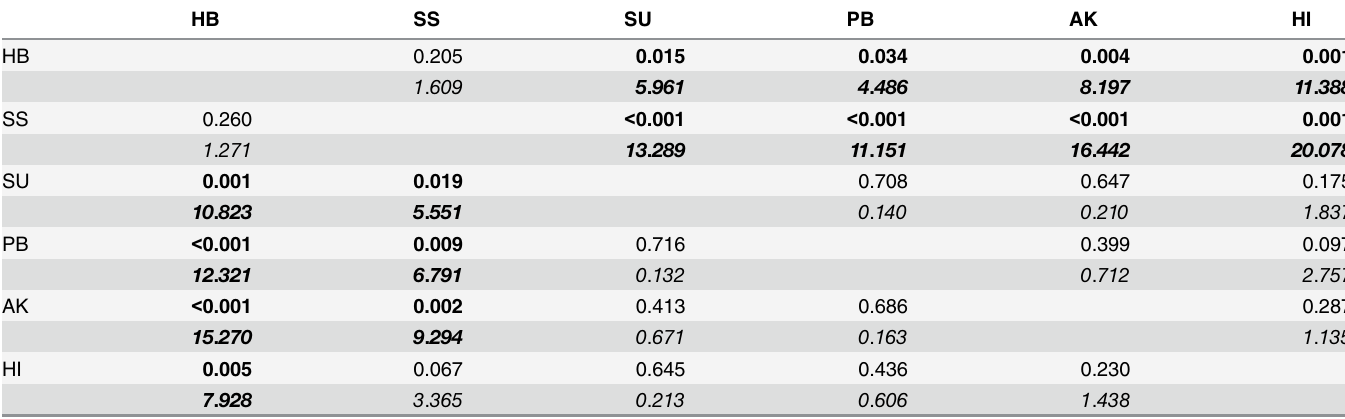
Above the diagonal refers to comparisons made for δ 15 N values. Below the diagonal refers to comparisons made for δ 13 C values. For each cell, the top number is the p-value and the bottom number (in italics) is the Chi 2 value. P-values < 0.05 and associated chi-square values are in bold. HB = historical breeders. SS = sequentially successful breeders. SU = sequentially unsuccessful breeders. PB = prebreeders. AK = Alaska fi sheries-associated birds. HI = Hawaii fi sheries-associated birds. Sample size of each category reported in Table